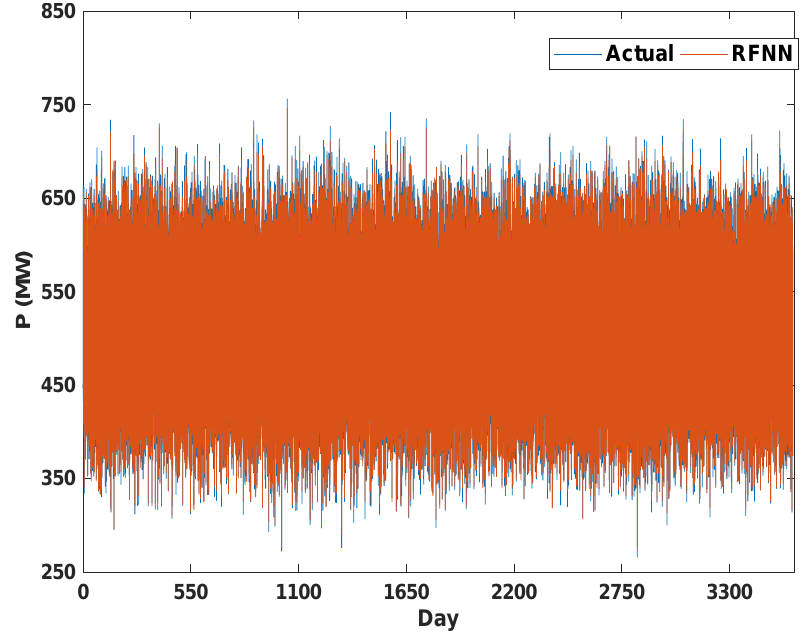
Figure 4. Recurrent fuzzy neural network training results with 10-year